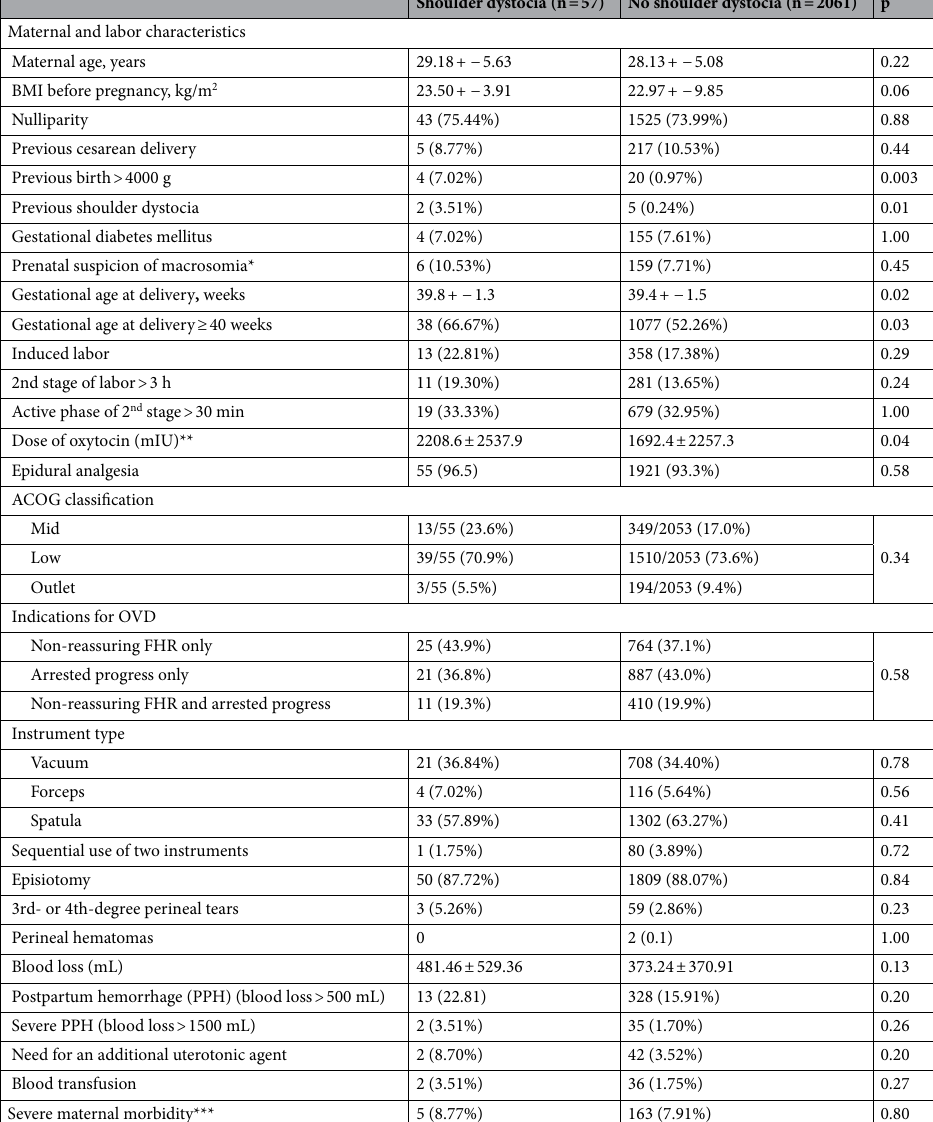
discrete data are expressed as n or n (%). Student’s t test, χ 2 test, non-parametric Mann–Whitney test, and Fisher’s exact test were used as appropriate. A P value of 0.05 was considered significant. *Prenatal suspicion of macrosomia: fundal height measurement at delivery > 37 cm and/or ultrasonographic fetal abdominal circumference > 90th p. for gestational age on Hadlock curves. **Dose of oxytocin: total dose received during labor, including the first and second stages of labor. ***Severe maternal morbidity was defined by at least one of the following criteria: third- or fourth-degree perineal tears, perineal hematomas, cervical laceration, extended uterine incision at cesarean delivery, PPH > 1500 mL 26 , surgical hemostatic procedure, uterine artery embolization, blood transfusion, infection (endometritis, episiotomy infection, wound infection needing surgery), thromboembolic event (deep vein thrombophlebitis or pulmonary embolism), admission to intensive care unit, and maternal